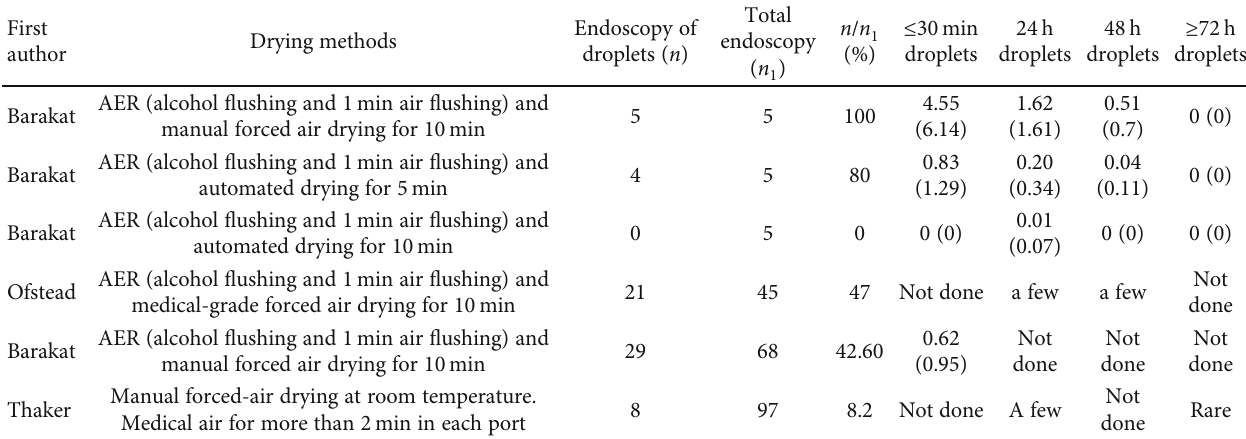
Table 4: Evaluation of the e ff ects of di ff erent drying methods on residual fl uid droplets in endoscopic working